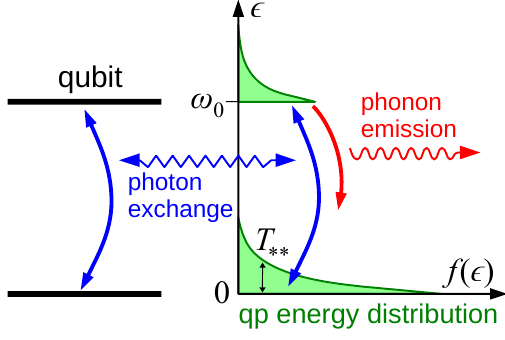
Figure 1: A schematic representation of the model under consideration. The quasi- particle distribution function f ( ε ) (shaded areas) is affected by photon exchange with e.g. a qubit and by the emission of phonons. As explained in the text, for “cold” quasiparticles the width T ∗∗ of the distribution function [ Eq. (11) ] is small compared to the photon frequency ω , and the distribution function has a second, smaller peak 0 at that frequency (replicas at higher multiples of ω can be neglected in the cold 0 quasiparticle